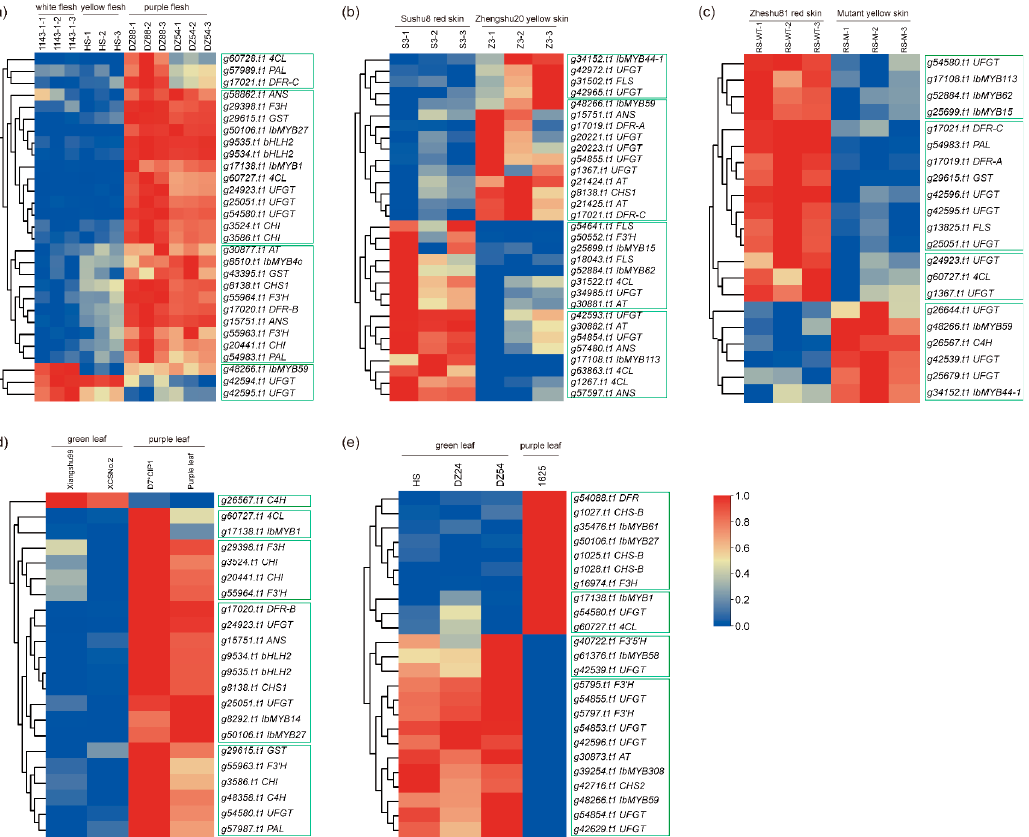
Figure 7. Expression pa tt erns analysis of di ff erentially expressed genes (DEGs) of IbR2R3-MYB and anthocyanin biosynthesis genes (ABGs) in di ff erent pigmented tissues of sweet potatoes. ( a ) IbR2R3-MYB s and ABGs in white, yellow, and purple fl eshes. ( b , c ) IbR2R3-MYB s and ABGs in red and yellow skins. ( d , e ) IbR2R3-MYB s and ABGs in green and purple leaves. The Log 2 (FPKM + 1) values were row scaled and displayed according to the color code. The red and blue colors represent the highest and lowest expression levels, respectively. The hierarchical clustering and green boxes in each heatmap show similar expression pa tt erns.